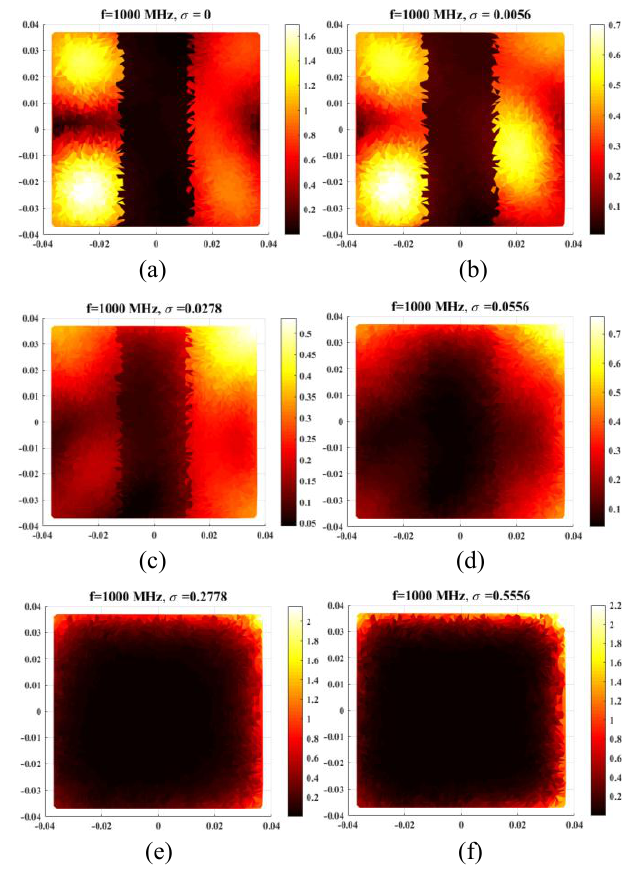
Figure 10: Distribution of fields in an inhomogeneous square scatterer illuminated by an incident field at 45 degrees to – x direction with increasing 𝜎